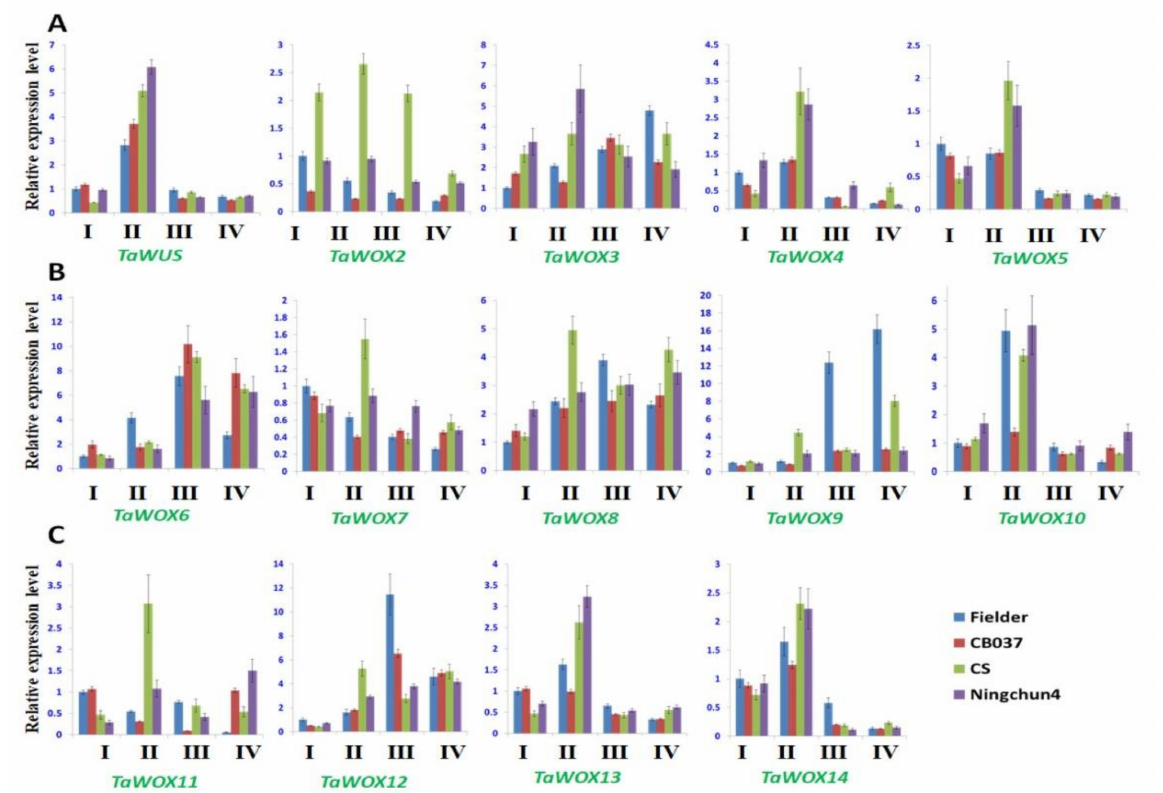
Figure 9. Expression patterns of TaWOX genes at different stage in callus proliferation of T. aestivum . The expression levels of 14 TaWOX genes in the immature embryos derived callus of four wheat cultivars Fielder, CB037, CS, and Ningchun4 at different culture stage were examined using qPCR. The qPCR data was normalized using wheat TaActin gene. Values were means ± sd of three biological replicates. I, fresh embryos; II, callus cultured for one week; III, callus cultured for two weeks; IV, callus cultured for three weeks. Expression pattern of TaWUS , TaWOX2 - TaWOX5 ( A ); expression pattern of TaWOX6 - TaWOX10 ( B ); TaWOX11 - TaWOX14 ( C ); were